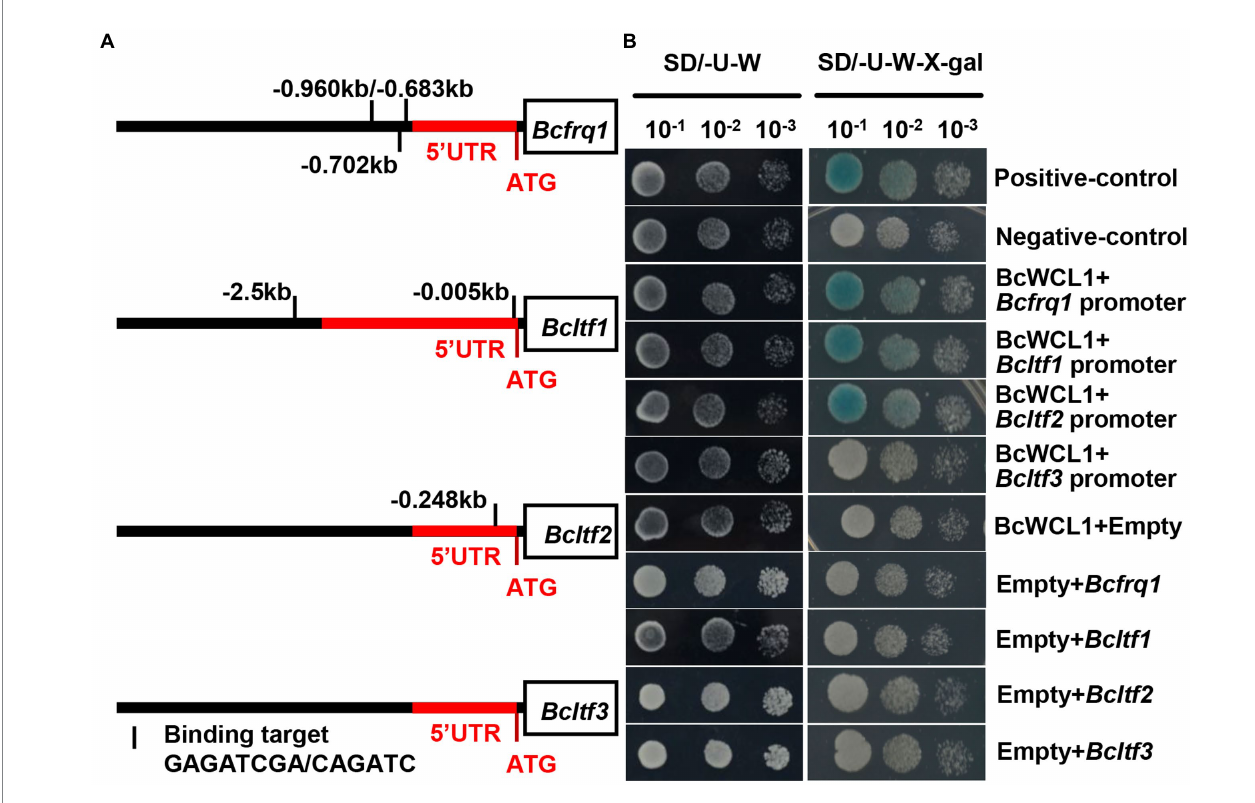
FIGURE 10 (A) WCC binding site analysis of the Bcfrq1 , Bcltf1 , Bcltf2 , and Bcltf3 promoter regions. The red and black regions represent the gene 5’UTR and the genome region before the 5’UTR, respectively. (B) Promoter binding evaluation of BcWCL1 and Bcfrq1 , Bcltf1 , Bcltf2 , and Bcltf3 by Yeast one-hybrid